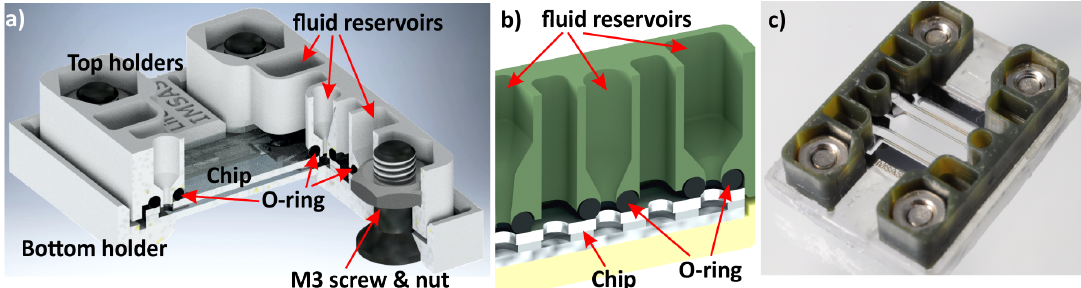
Figure 5. The assembly of a microfluidic chip and holder (22mm × 29mm × 8mm). The chip is sandwiched between two top holder parts and a bottom holder. The three printed parts are fixed by M3 screws and nuts. Liquid reservoirs, integrated in the top holder, have a volume of 20–40 µ L and are connected with O-rings to the chip inlets. ( a ) The schematic; ( b ) cut-out visualizing the fluid reservoirs and O-rings; and ( c ) a photo of the